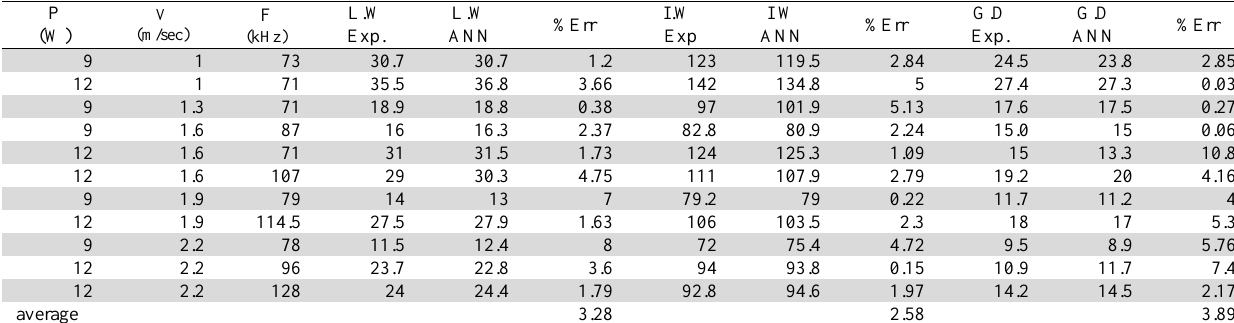
Optimum LDS parameters for the Ra 5 (µm)